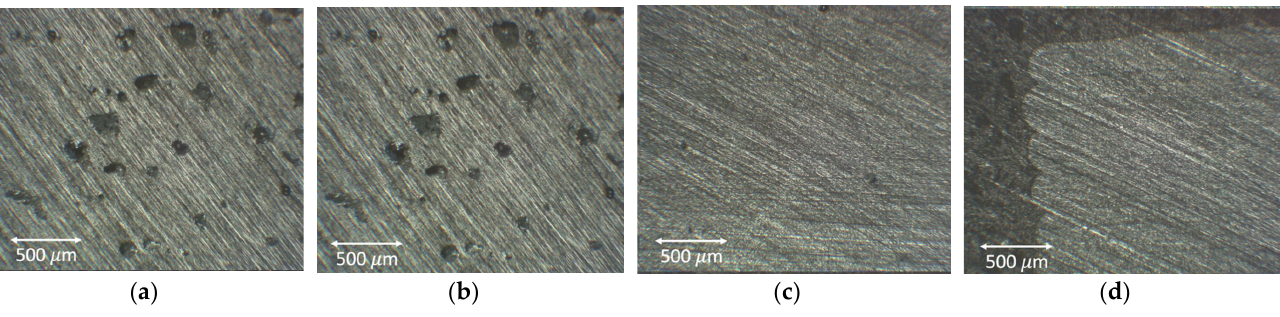
Figure 8. Microstructure of the tensile specimens, ( a ) and ( b ) are undried, ( c ) and ( d ) are dried. ( a ) and ( c ) images are taken in the center of the section, while ( b ) and ( d ) are taken on the side, with the ends of the layers visible. The left images (i.e., undried), both in the center and side of the section, show voids with different dimensions, up to 0.3 mm, produced by the expansion of moisture during extrusion.